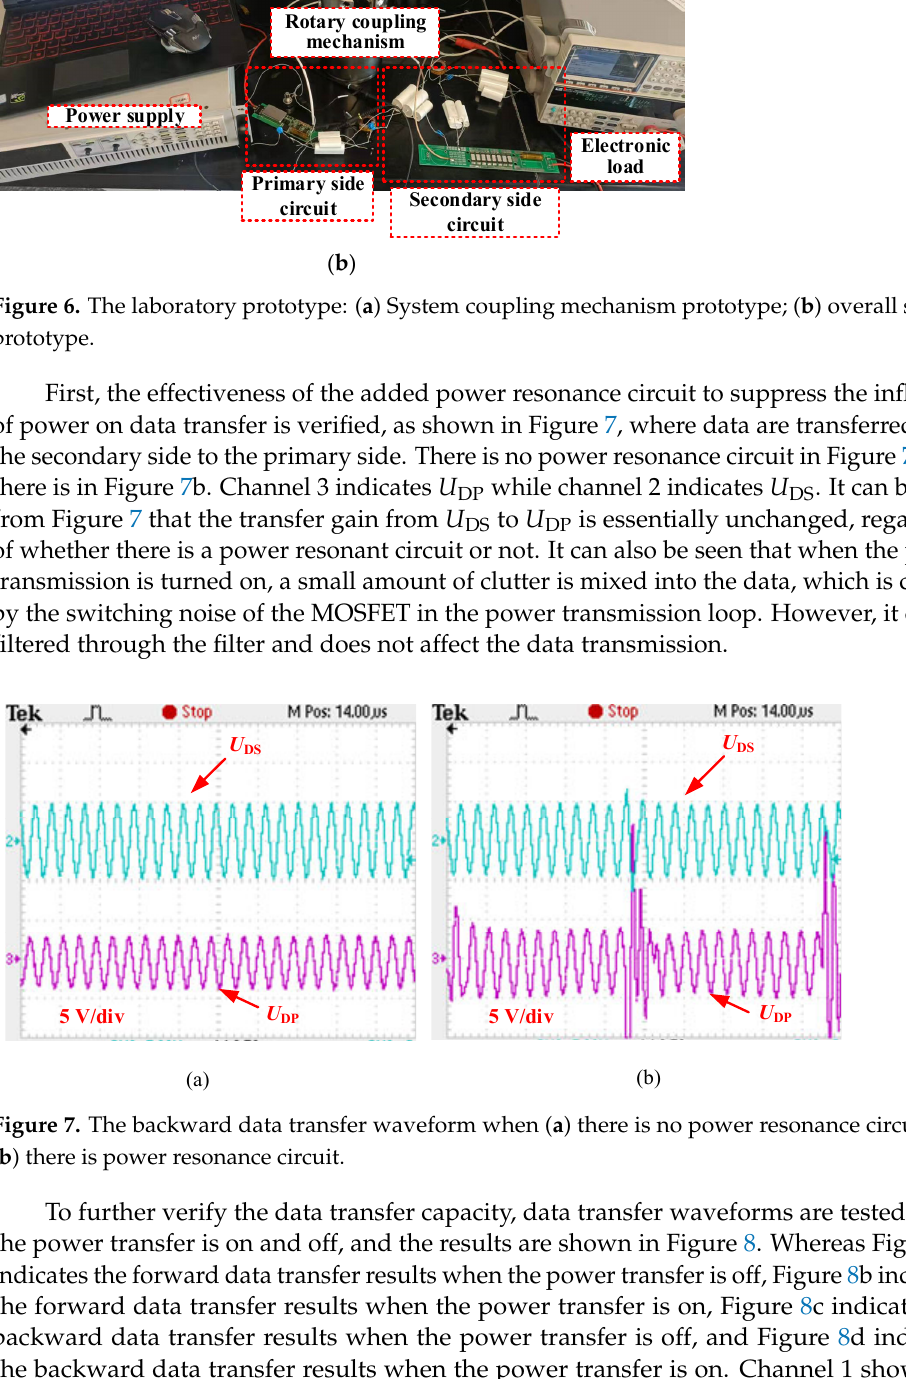
(d) Figure 8. ( a ) The forward data transfer results when power transfer is off; ( b ) the forward data trans ‐ fer results when power transfer is on; ( c ) the backward data transfer results when power transfer is off; ( d ) the backward data transfer results when power transfer is on.